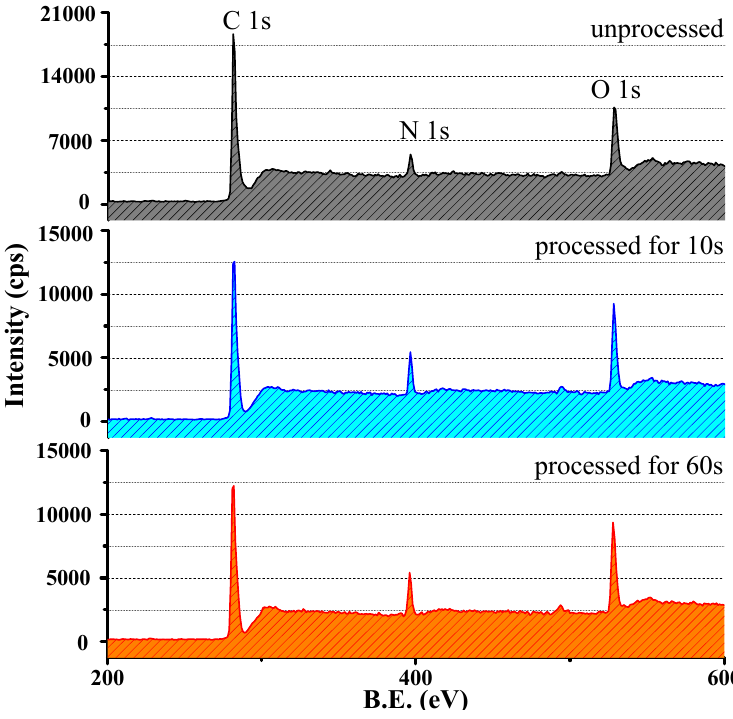
Figure 5. X-ray photoelectron spectroscopy (XPS) scan of unprocessed PA66 fabric and the glow-like plasma processed samples.